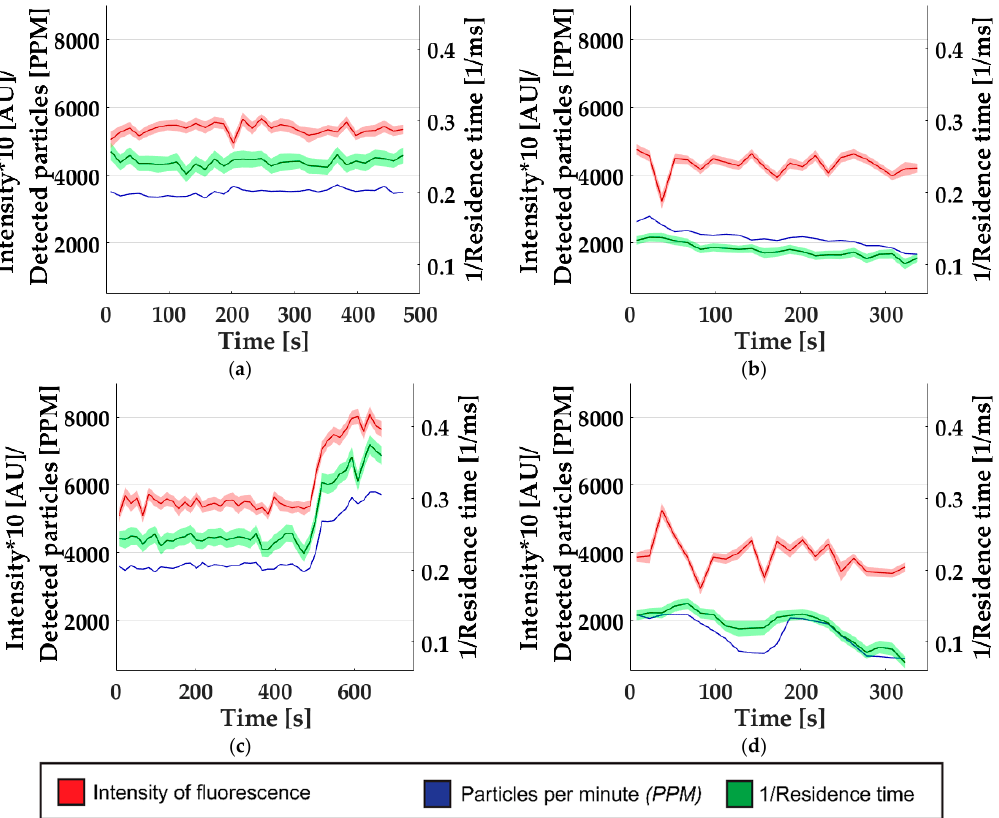
Figure 5. Detected perturbations of the online synthesis. Colored areas represent the standard error of the average value for 15 s measurement frames. ( a ) No incidents. ( b ) Drifting change. ( c ) Incident in synthesis. ( d ) Clogging.